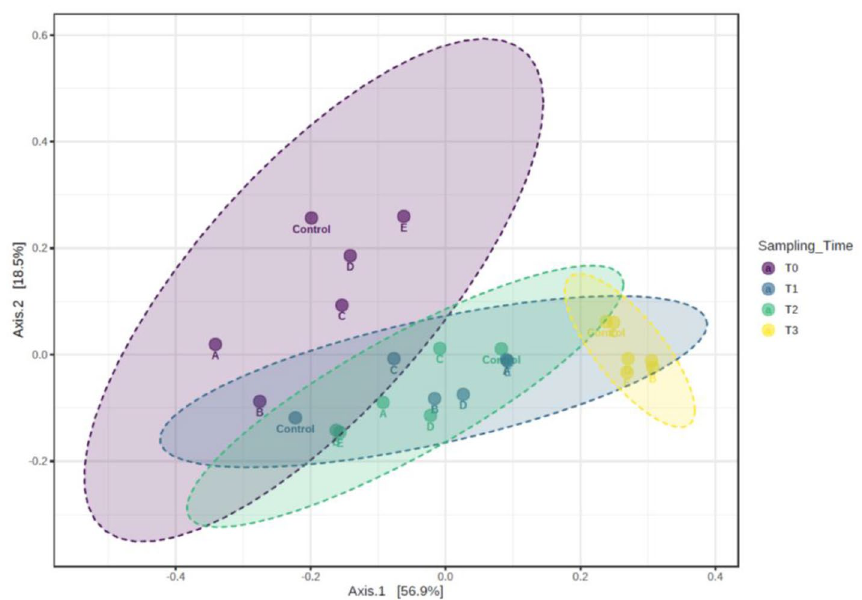
Figure 4. Principal coordinate analysis (PCoA) based on Bray Curtis ß-diversity. The plot illustrates the distances between bacterial communities in all individual fecal samples (A: Lactobacillus acidophilus CRL 2074 ; B : Limosilactobacillus fermentum CRL 2085 ; C: Limosilactobacillus mucosae CRL 2069 ; D: CRL 2085 + CRL 2069 ; E: CRL 2074 + CRL 2085 + CRL 2069 treated and untreated (control) at different sampling times (T0, T1, T2 and